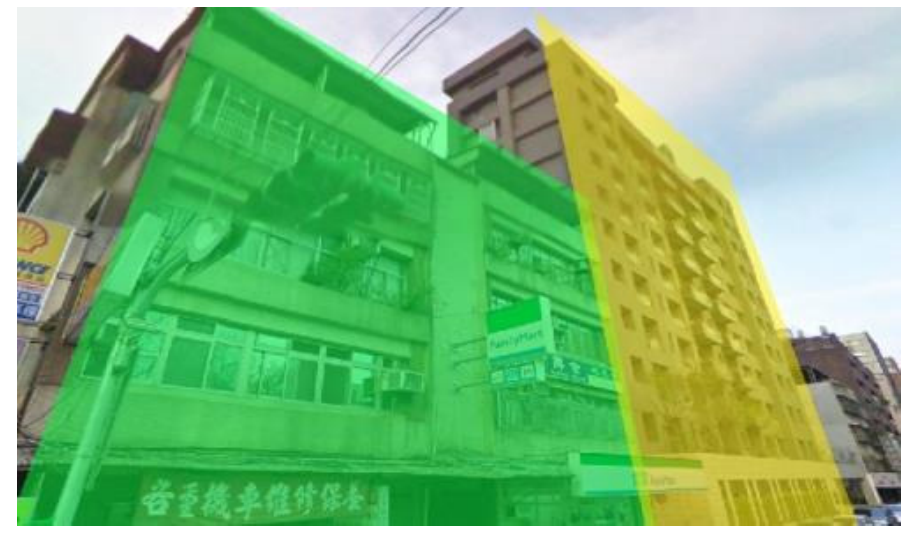
Figure 17. Overlaid result of street view image and façade pieces.